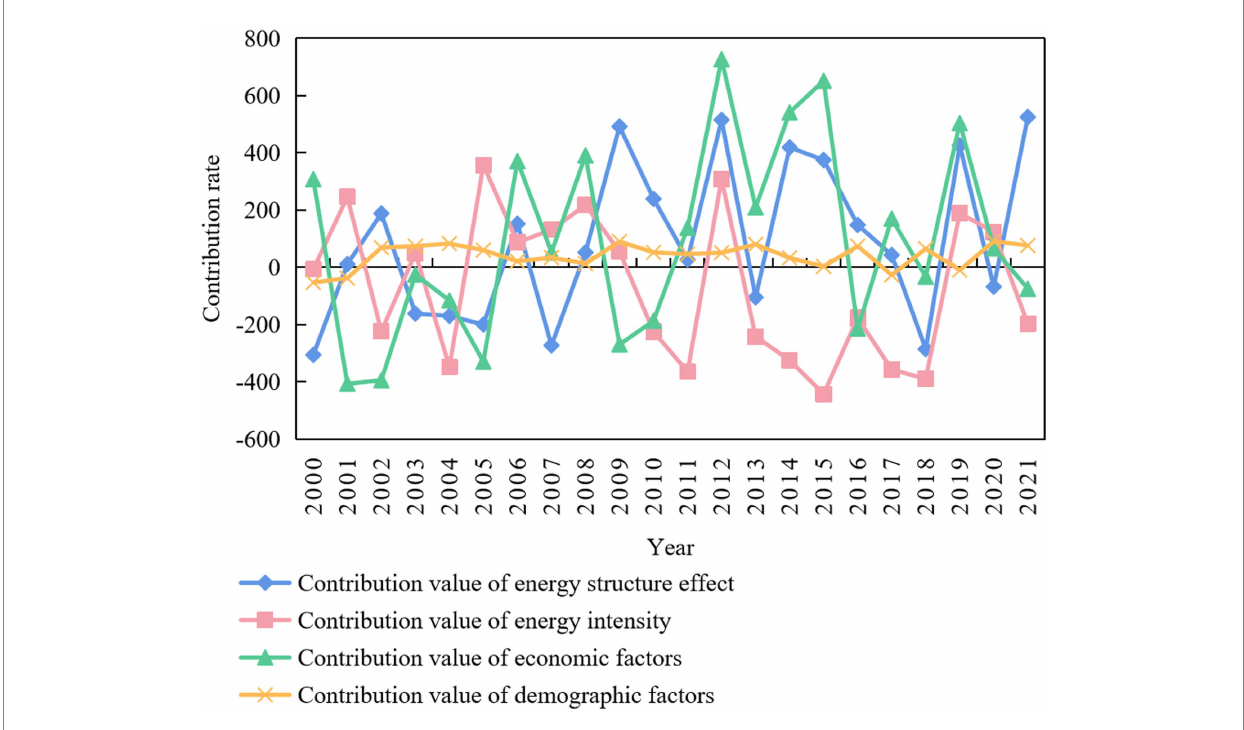
FIGURE 4 Contribution rate of CDE